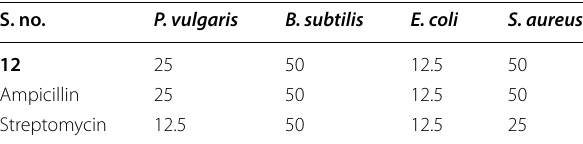
Table 3 Antimicrobial activity of 2-aminothiophene